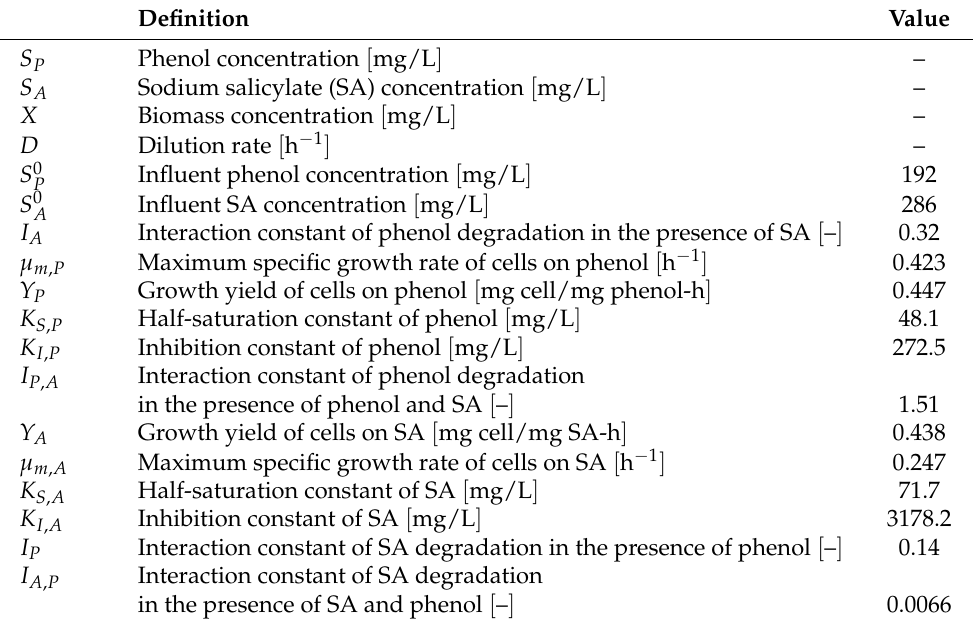
Table 1. Model variables and parameters.